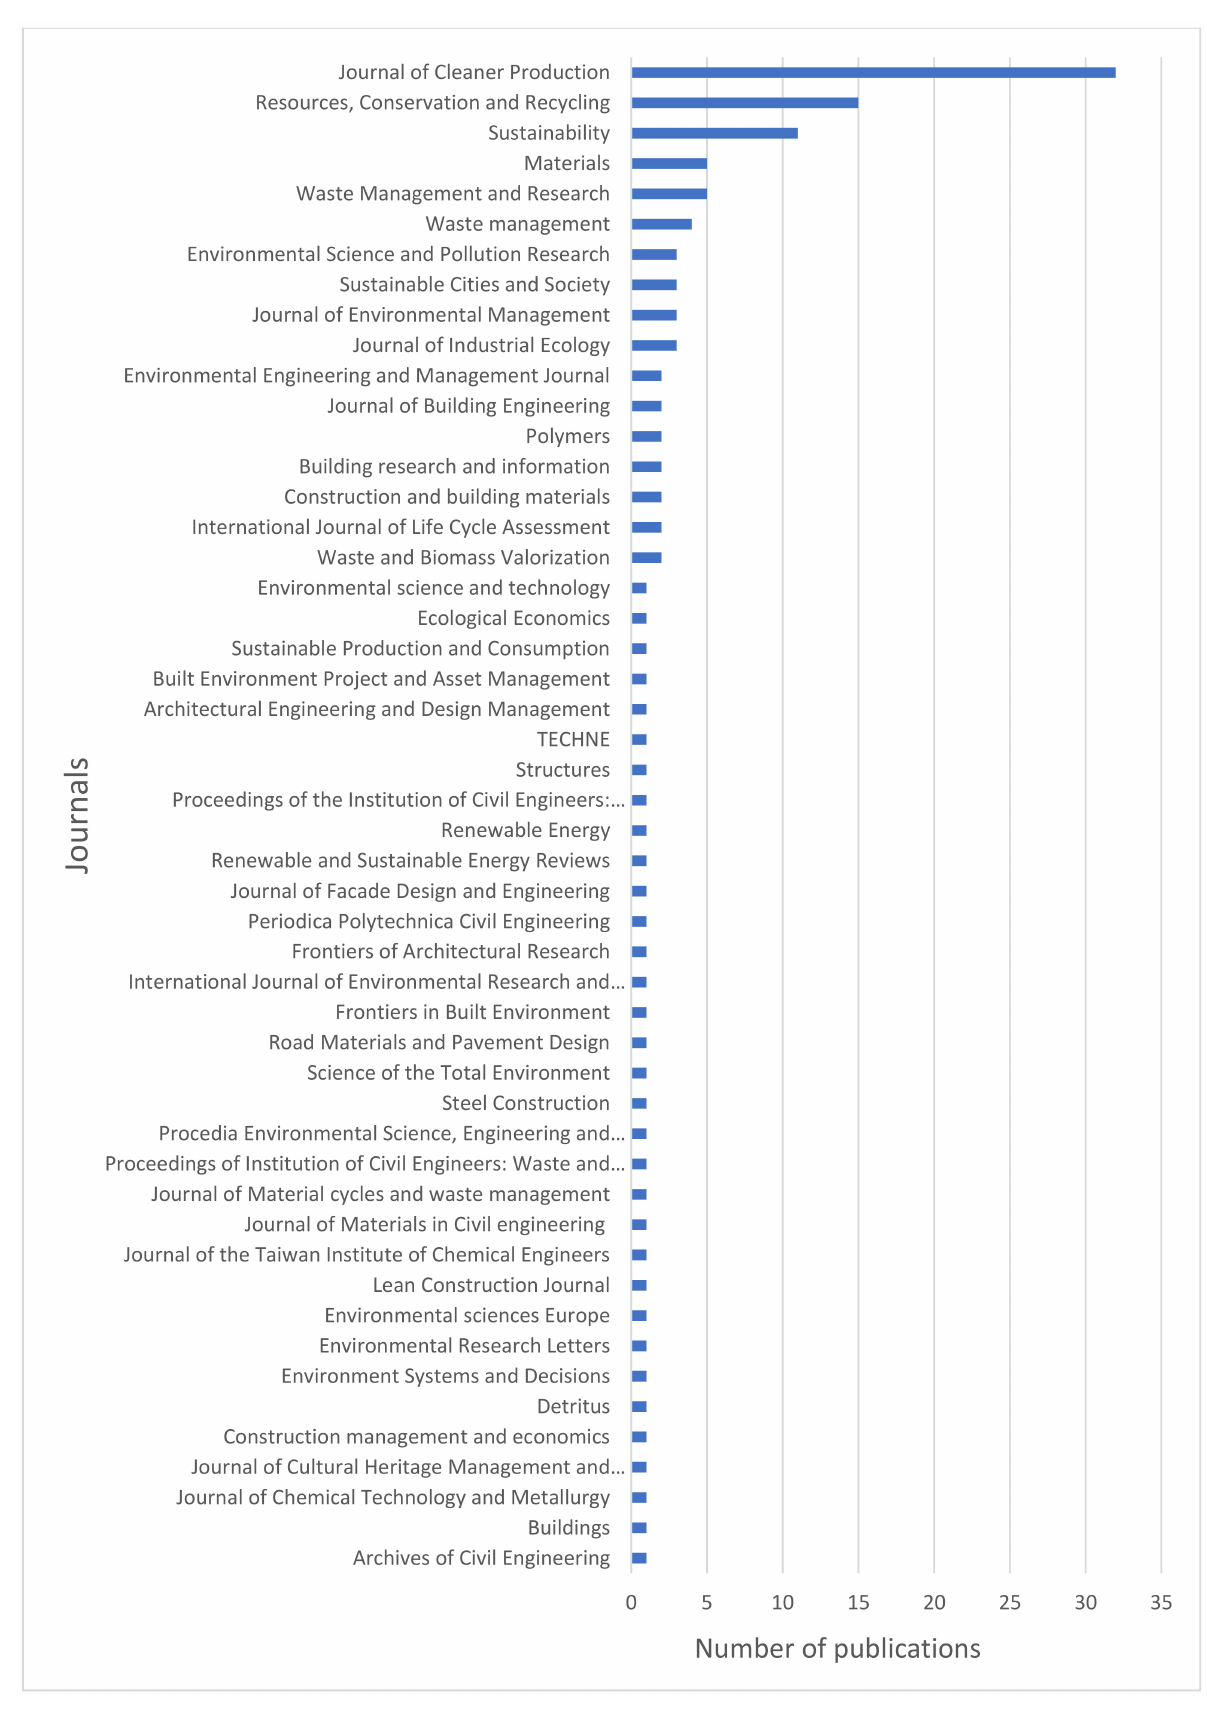
Figure 4. Sources